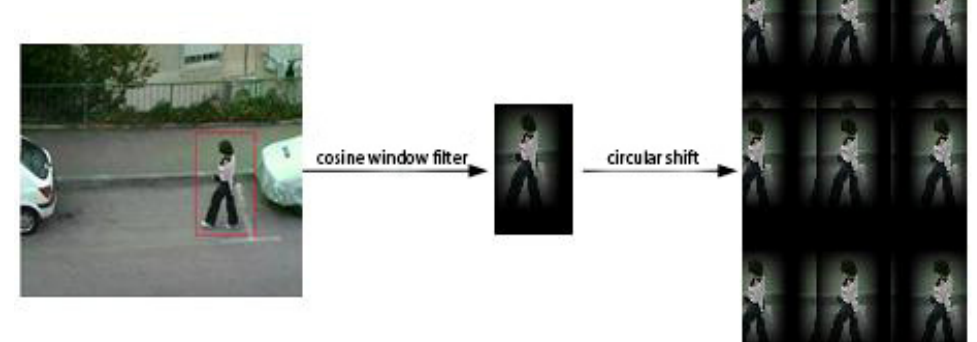
Figure 5. Extraction process of cyclic samples.